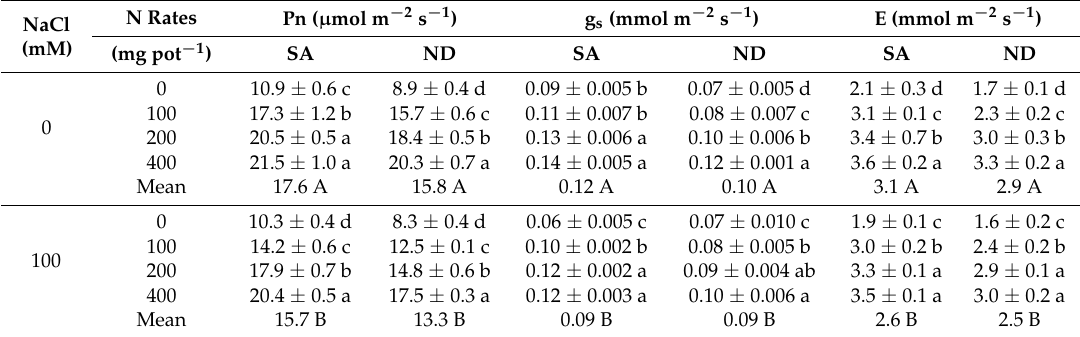
Table 3. Effects of salinity and nitrogen rate on the photosynthetic rate (Pn), stomatal conductance (g s ), and transpiration rate (E) of the two oat genotypes (SA vs. ND) at the flowering stage in the first run of a controlled greenhouse study.